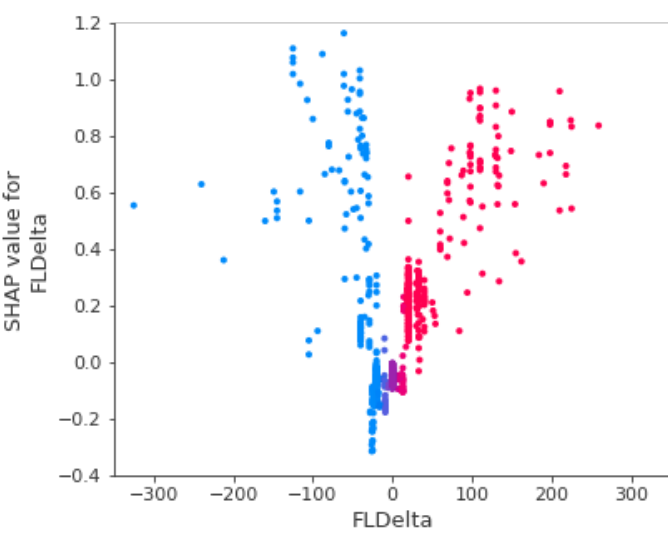
Figure 15. SHAP values (classification) of FLDelta for Sector 1.